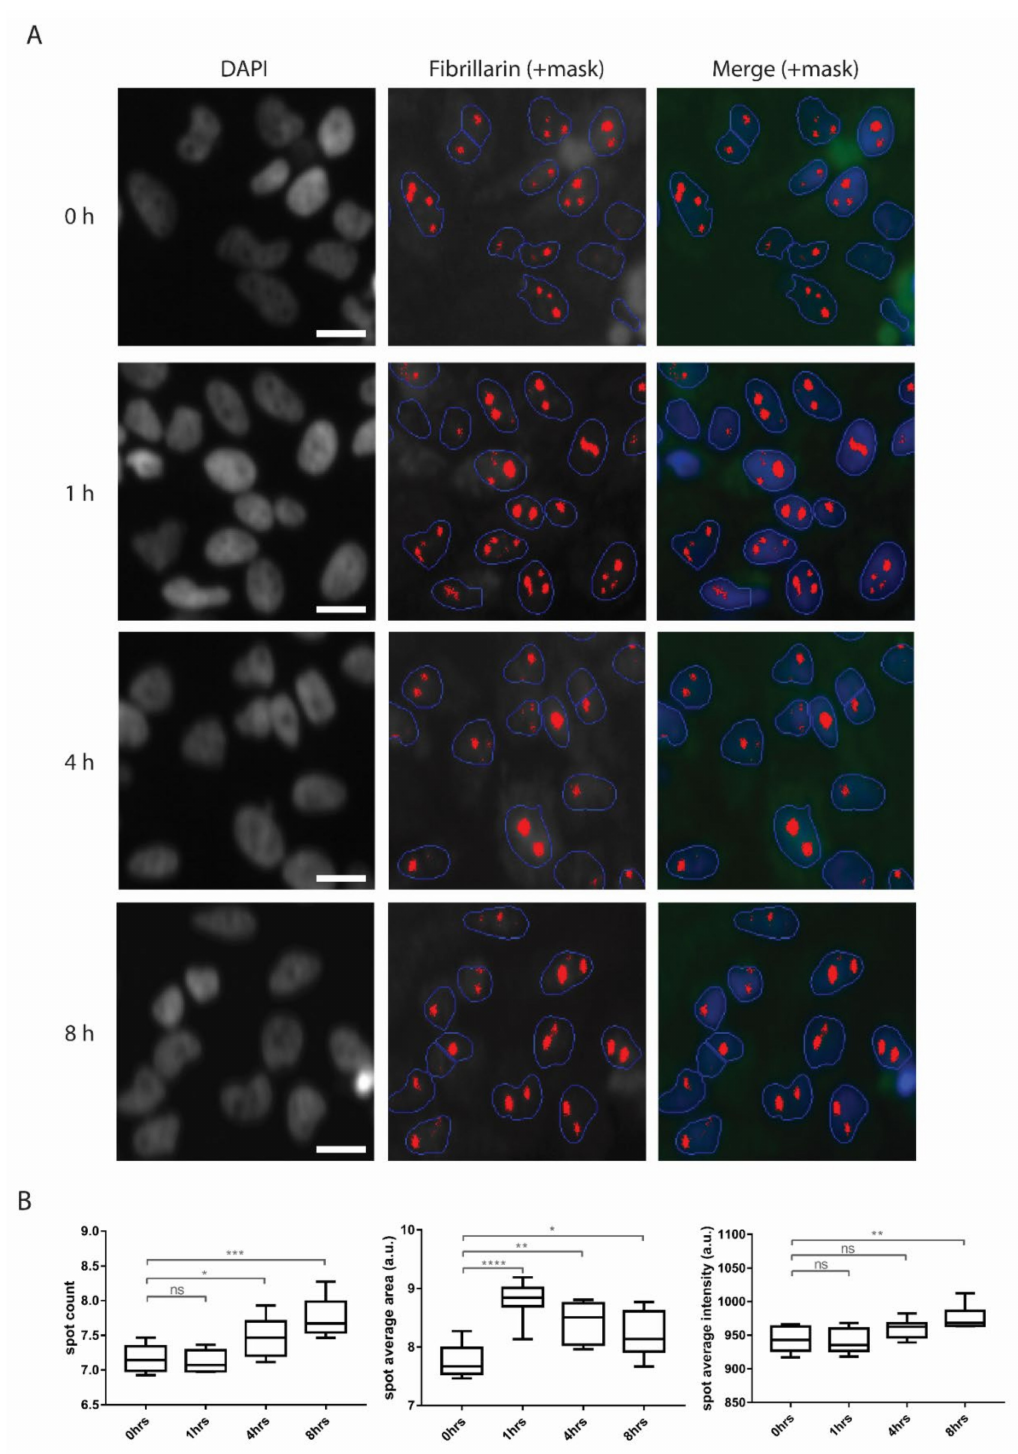
Figure 6. ( A ) Representative IF pictures of fibrillarin stained cells with a mask used for quantification by high-content screening (HCS) platform. Scale bar is 5 µ m. ( B ) Quantification of HCS staining shows increase in size, intensity and number of fibrillarin-positive spots upon penetratin treatment. Significance: * p < 0.05, ** p < 0.01, *** p < 0.001, **** p < 0.0001, ns not